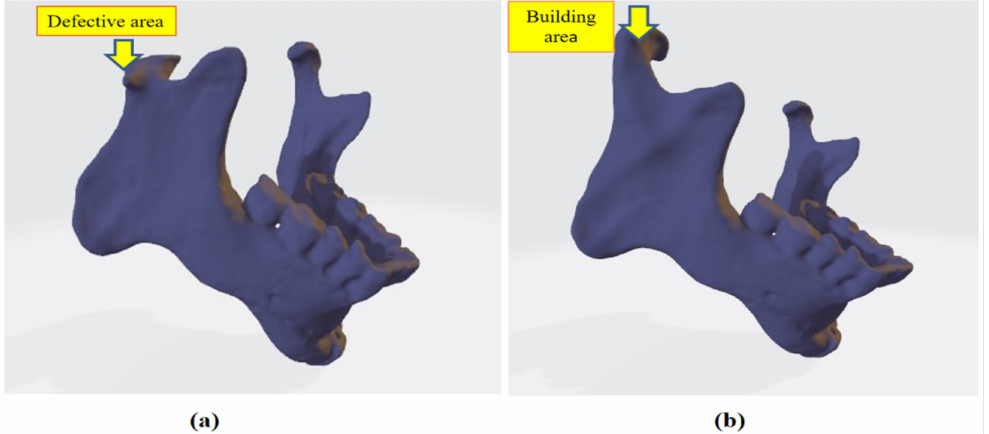
Figure 1. ( a ) The mandible jaw with damaged condyle, and ( b ) Later on rebuild model. Afterward, for the generation of the mandible jaw of the patient, the file in IGES format was imported into the ANSYS workbench. Main steps concerning the design and numerical simulation of patient-specific TMJ Implant are represented in Figure